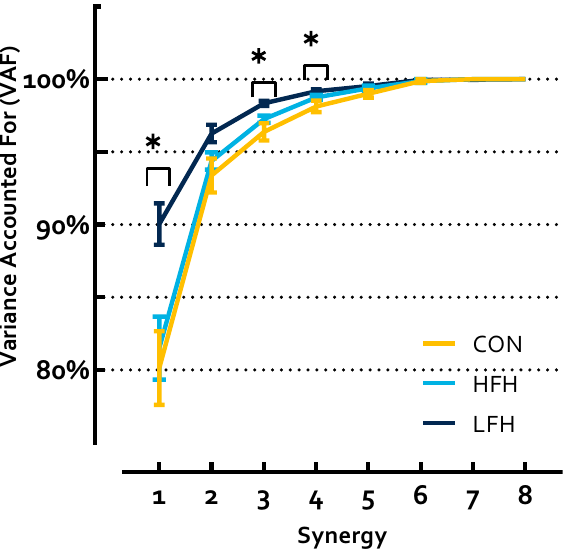
Figure 2. VAF accounted for by each synergy. LFH individuals exhibited greater VAF in the 1st synergy than CON and HFH, and in the 3rd, and 4th synergies compared to CON. HFH and CON did not differ. Asterisks denote a p < 0.05.